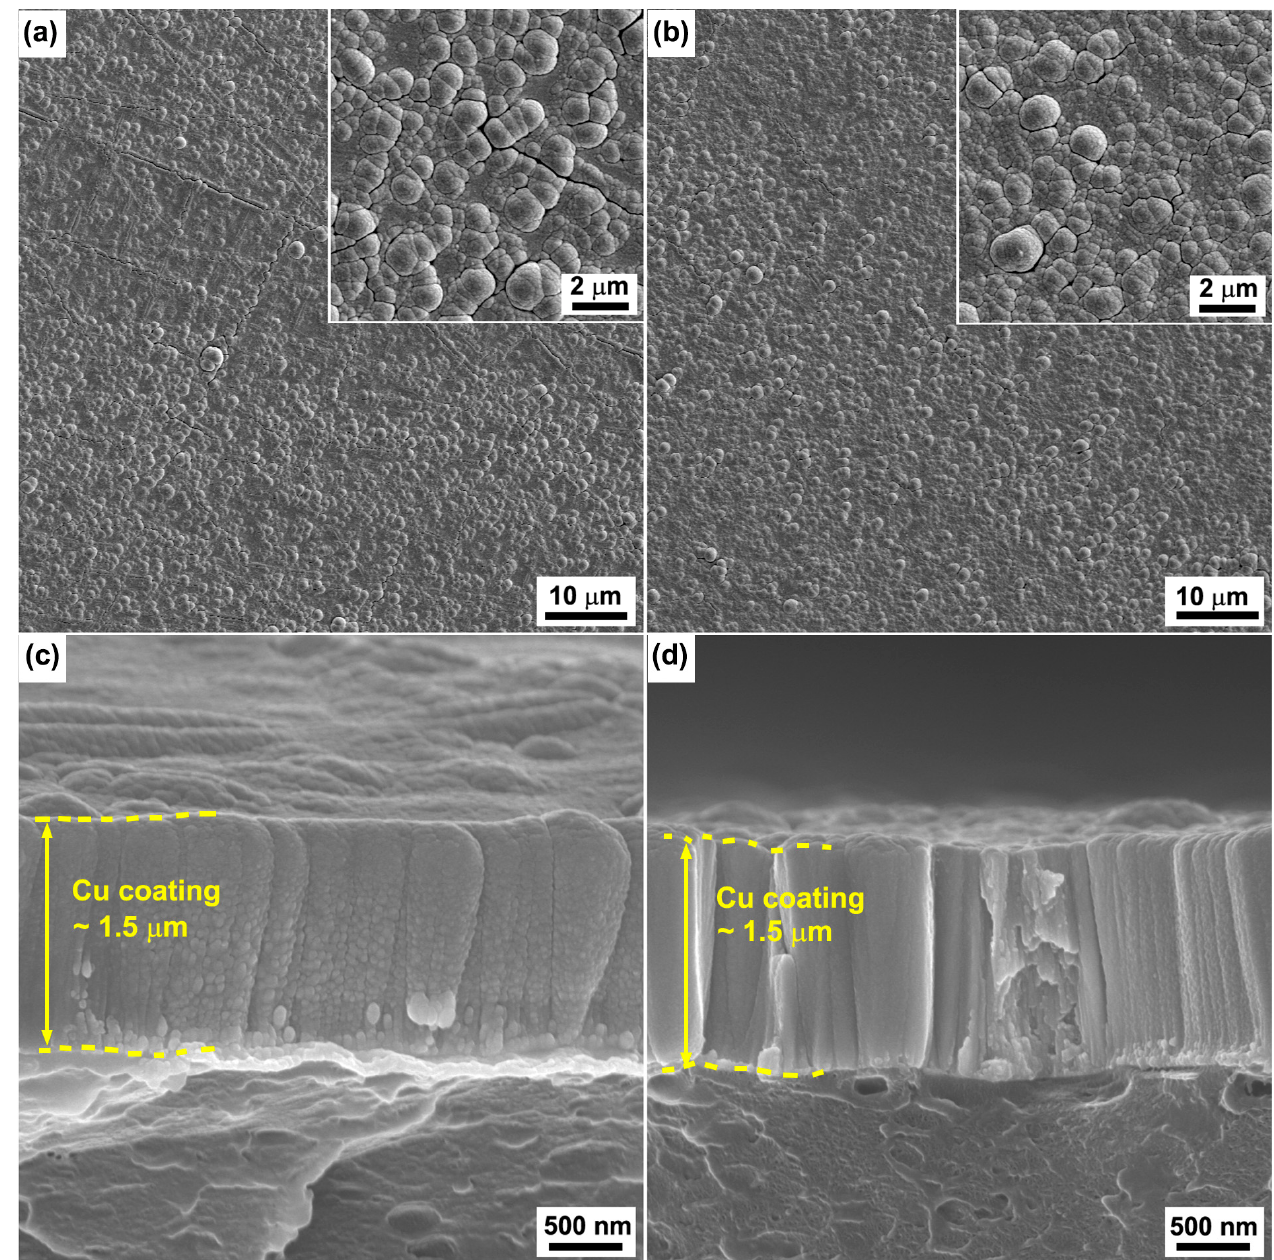
Figure 6. Typical surface SEM images of the Cu coatings deposited on the ABS substrates treated by Cr ions with bias voltages of − 600 V ( a ) and − 1000 V ( b ) for 30 s. ( c ) and ( d ) are the corresponding cross-sectional images of ( a ) and ( b ), respectively.